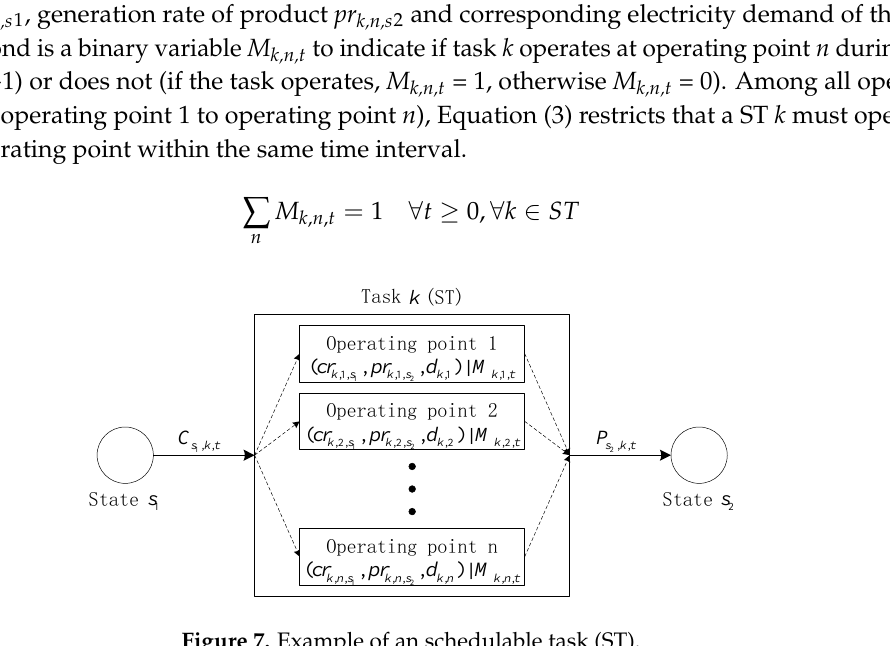
Figure 7. Example of an schedulable task (ST).